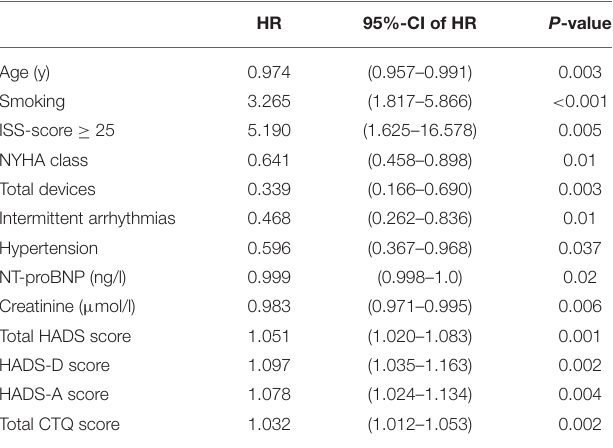
TABLE 2 | Univariate predictors of (non)-adherence to medication.